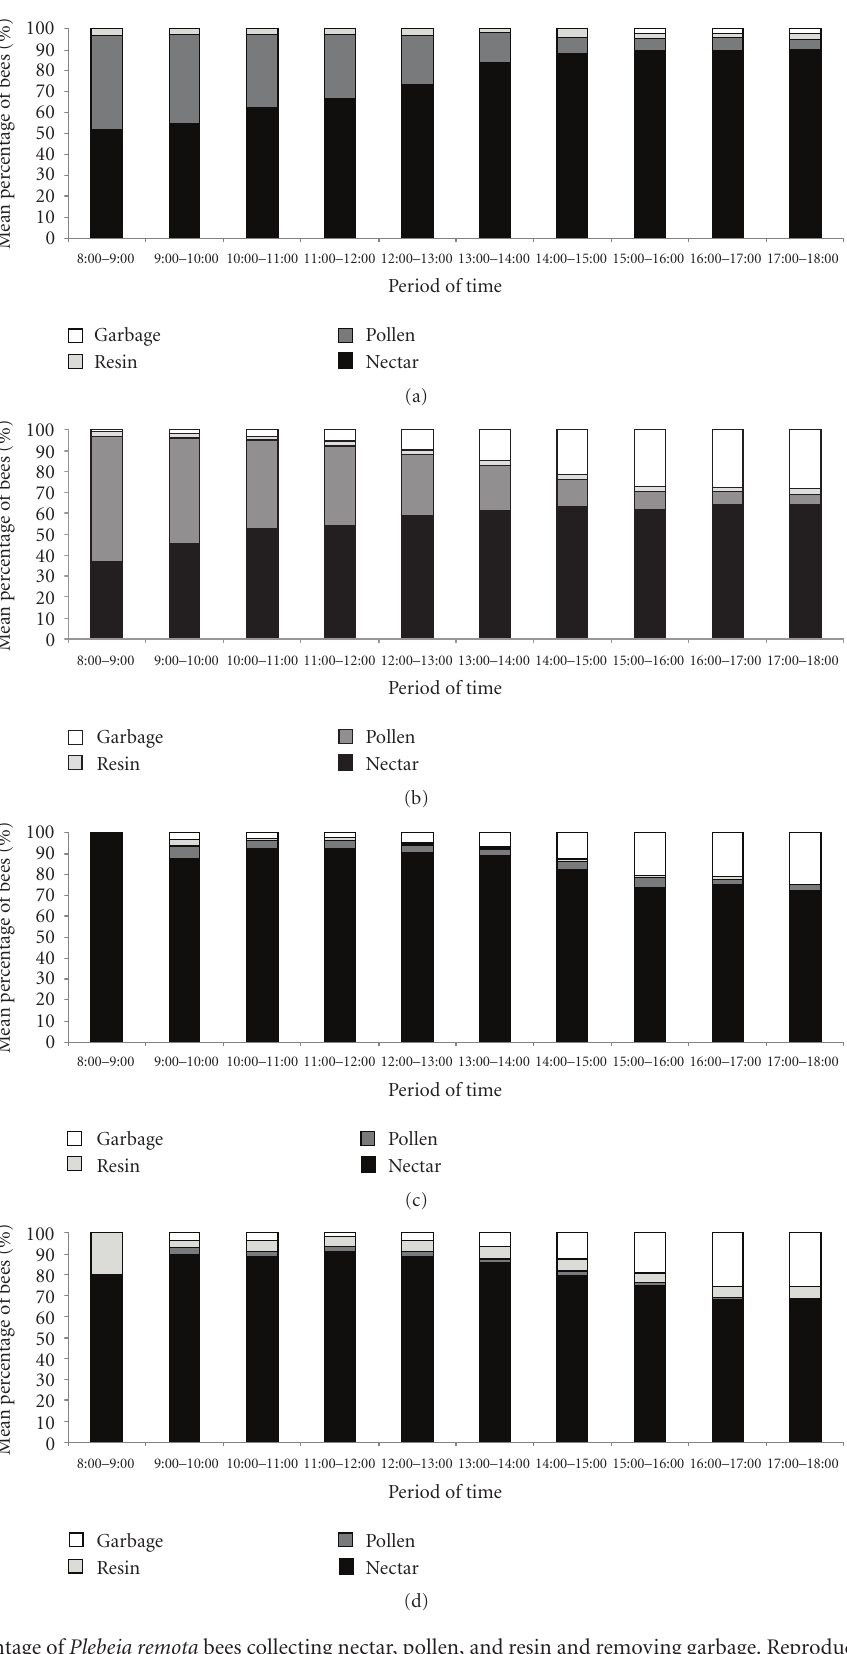
Figure 7: Mean percentage of Plebeia remota bees collecting nectar, pollen, and resin and removing garbage. Reproductive phase: (a) colony 1; (b) colony 2. Diapause: (c) colony 1; (d) colony